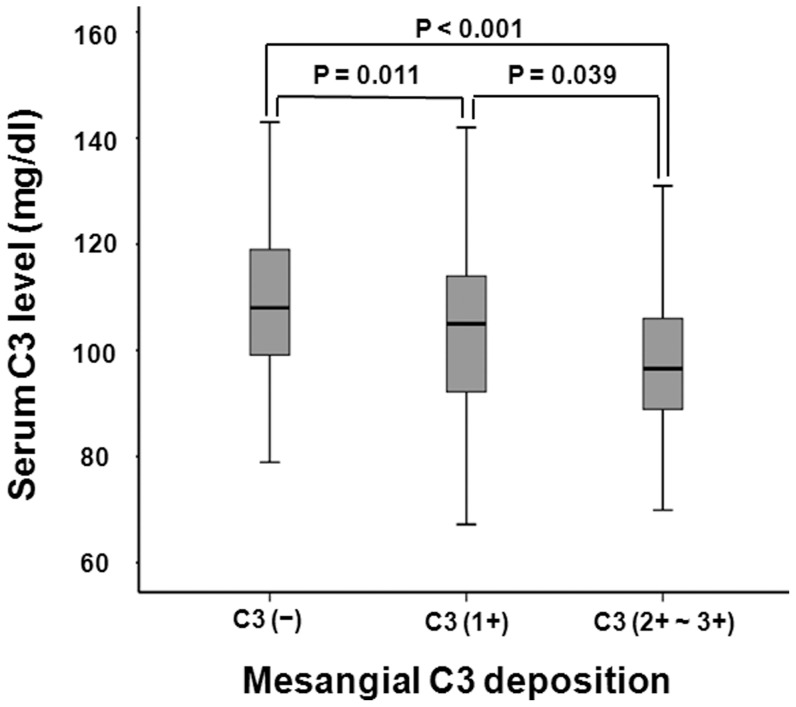
Comparison of serum C3 levels according to mesangial C3 deposition.Serum C3 levels decreased significantly from 0 to 2+∼3+ mesangial C3 deposition (0, 111.7±18.0; 1+, 104.3±17.1; 2+∼3+, 98.6±14.2 mg/dl; P<0.001).